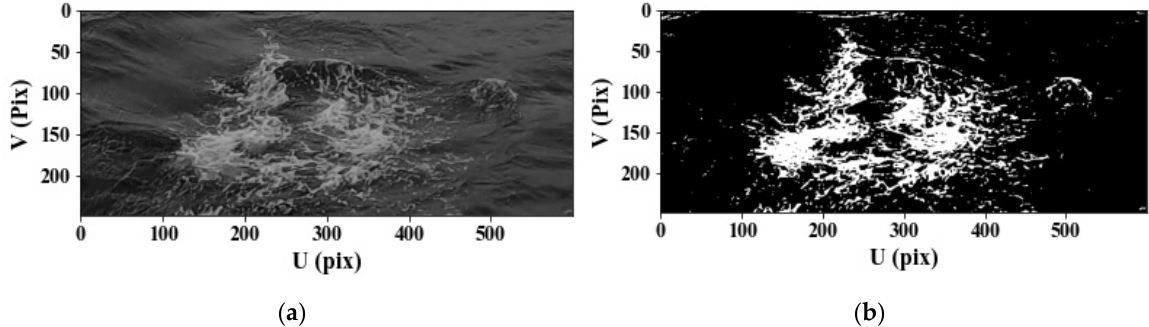
Figure 5. ( a ) Residual whitecaps in a visible image; ( b ) thresholding result of the left